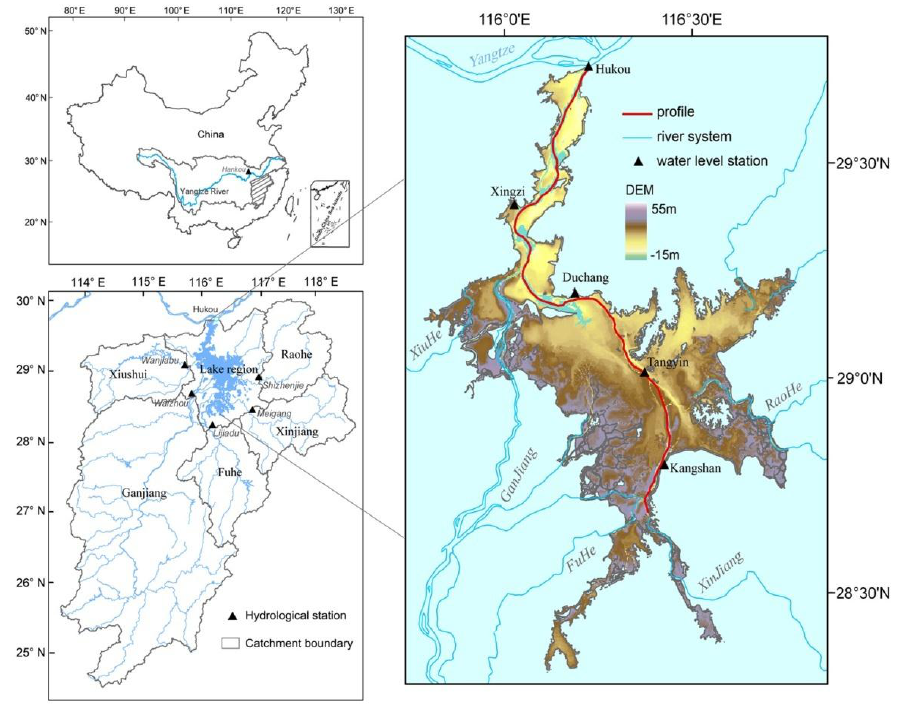
Figure 1. Geographical location of Poyang Lake in China. The channel water surface profile from north to south is indicated by the red